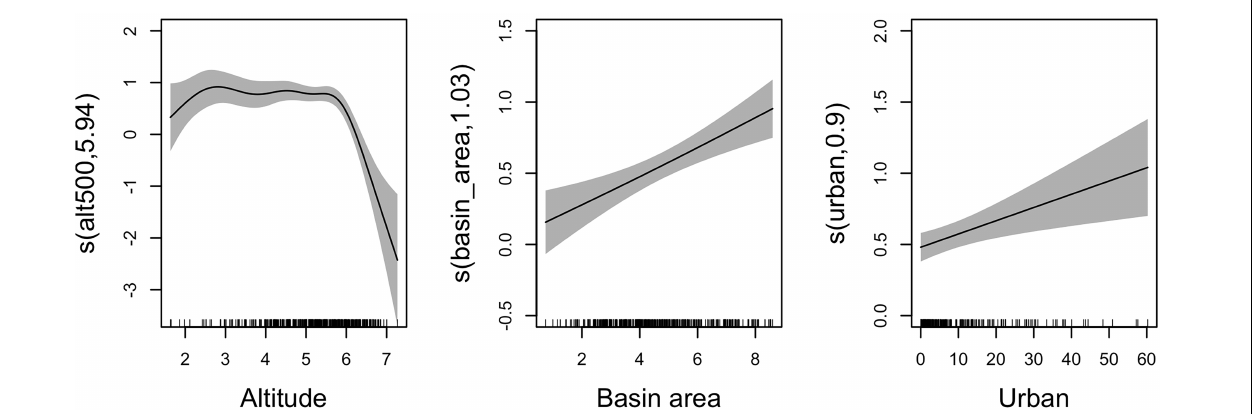
FIGURE 2 | Smooth functions (black lines) for the predictor variables “altitude”, “basin area”, and “urban area”. The gray shading represents the 95% confidence intervals. The number in brackets on the vertical axis labels is the effective degrees of freedom of the smooth term (1 corresponds to a linear term). TABLE 2 | Results of the generalized additive model explaining values of richness of invasive alien plants in riparian ecosystems. Covariates edf Ref.df Chi.sq p -value Altitude 5.94 9 52.06 < 2e-16*** Basin area 1.03 9 19.87 3.55e-06*** Urban 0.90 9.46